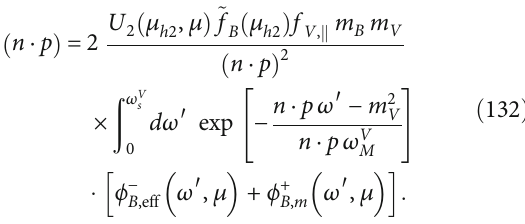
Figure 5: Diagrammatic representation of the vacuum-to- B -meson ð p , q Þ de fi ned with the A 0 -type SCET correlation function Π B ν , k (cid:1) ξ Þ γ = ð , the leading power interpolating operator O ð A 0 Þ W h c v 5 k and the subleading power SCET Lagrangians L ð 1 Þ ξ current j ð 0 Þ ξξ , ν L ð 1 Þ ξ m